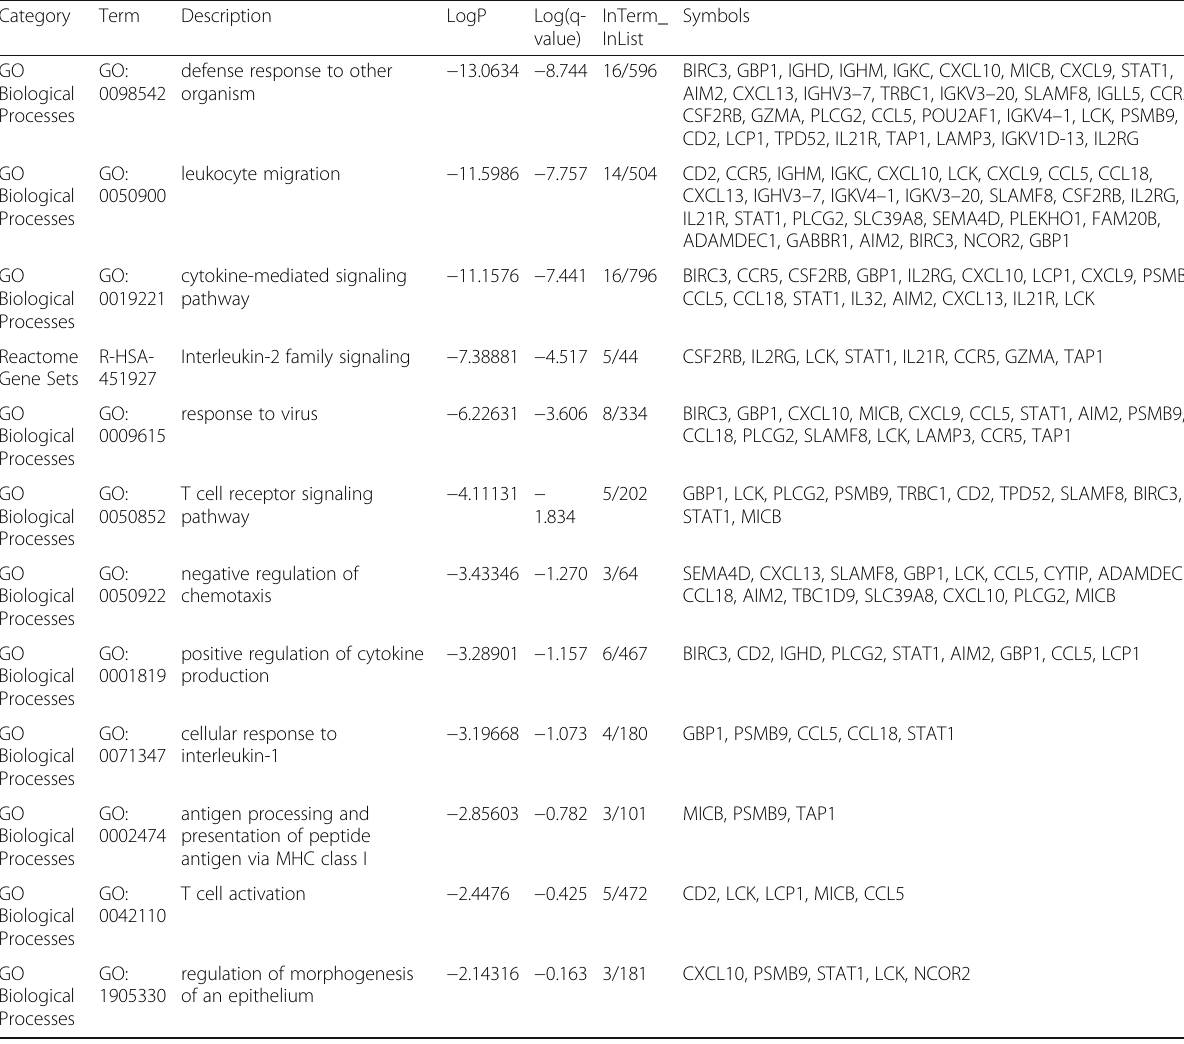
Table 2 Top Pathways enriched in the DEGs specific to RA compared to healthy and OA